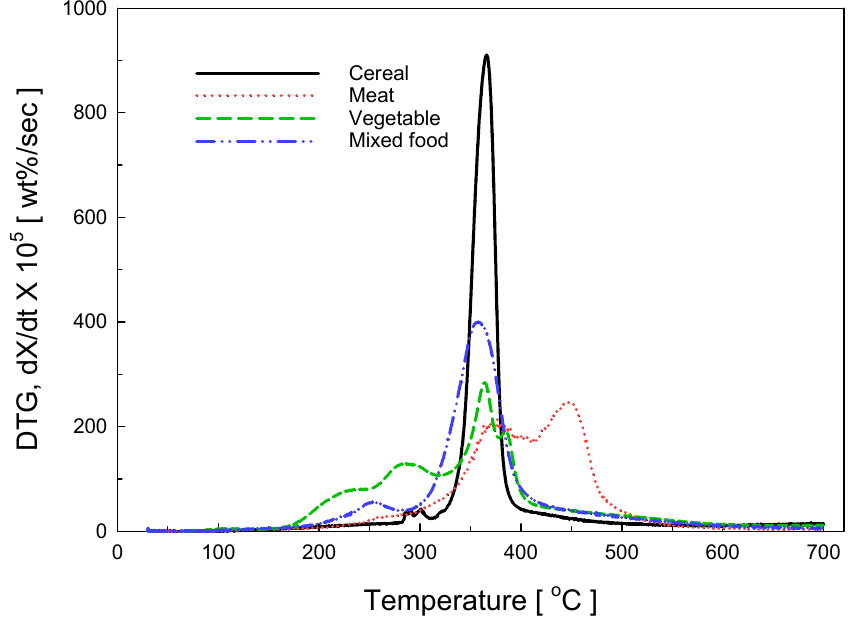
Figure 6. DTG curves of cereal, meat, vegetables, and mixed food pyrolysis at heating rates of 20 °C/min.